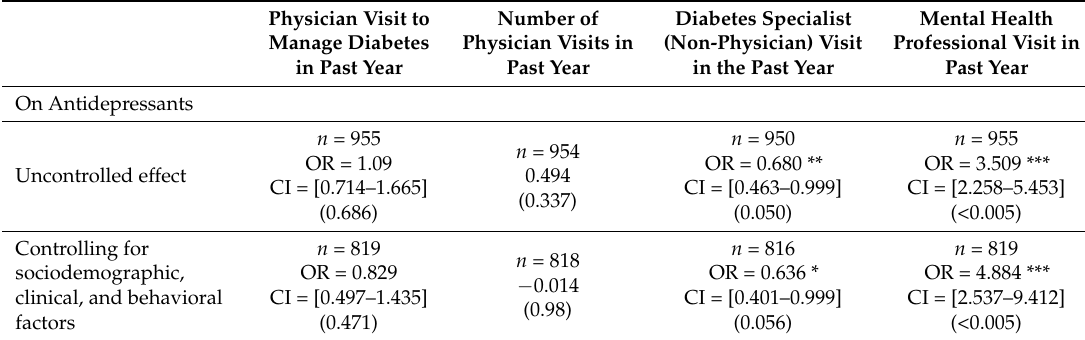
Table 6. Coefficients and levels of significance for the association between use of antidepressants and professional healthcare use.